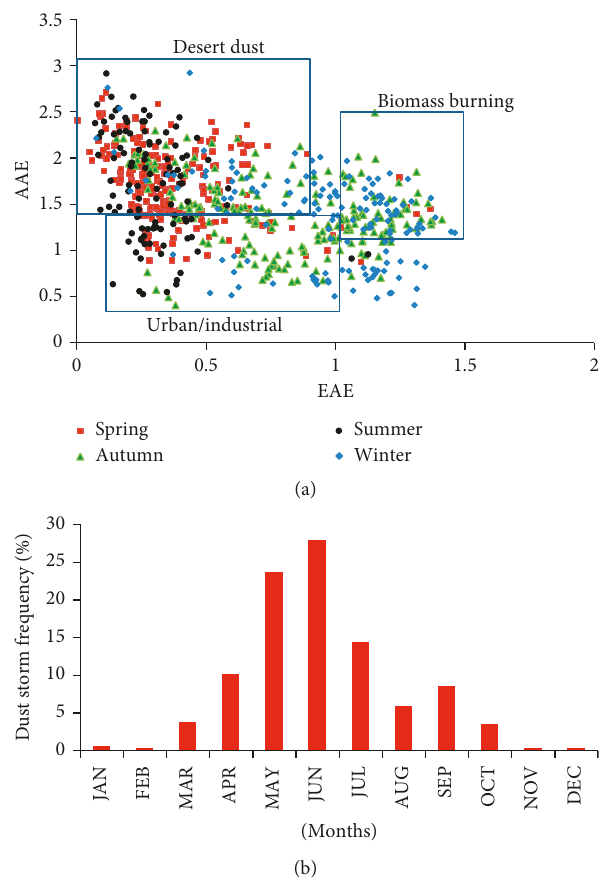
Figure 5: (a) Classification of aerosols during seasons of spring (MAM), summer (JJA), autumn (SON), and winter (DJF) using the scatter plot of daily average absorption ˚Angstr¨om exponent (440–870) (AAE) versus extinction ˚Angstr¨om exponent (440–870) (EAE) over Karachi and (b) dust storm frequency over central region of Pakistan during the study period.